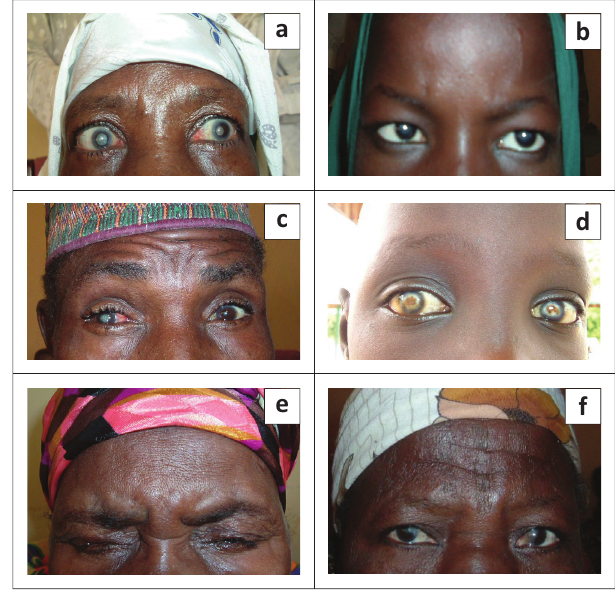
FIGURE 1: Images of eye conditions used to assess coucher’s knowledge and practices: (a) cataracts; (b) cataracts in a child; (c) traumatic cataracts; (d) corneal scarring; (e) trachomatous trichiasis; (f)